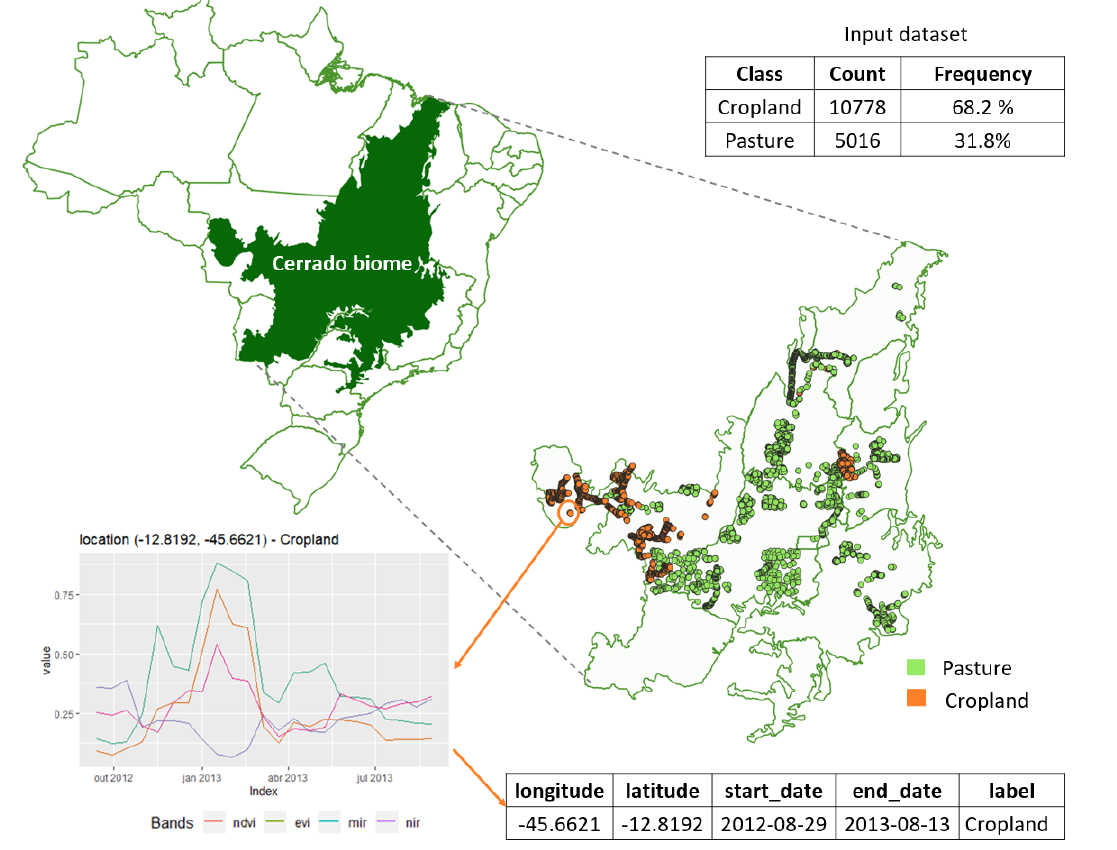
Figure 1. Land use samples dataset of Cerrado